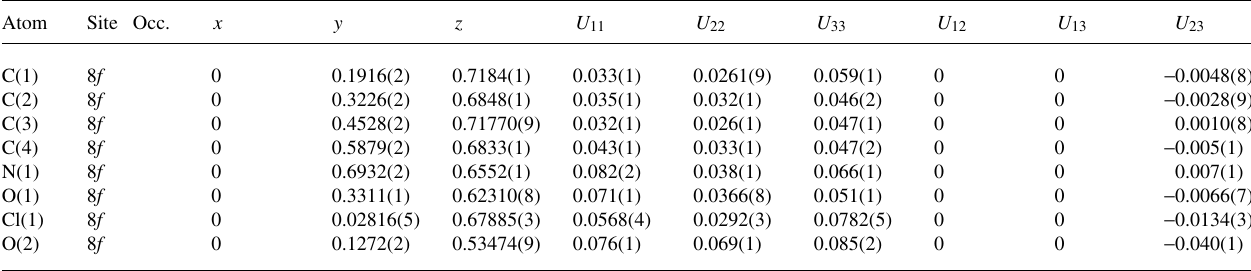
Table 3. Atomic coordinates and displacement parameters (in Å 2 ) . Atom Site